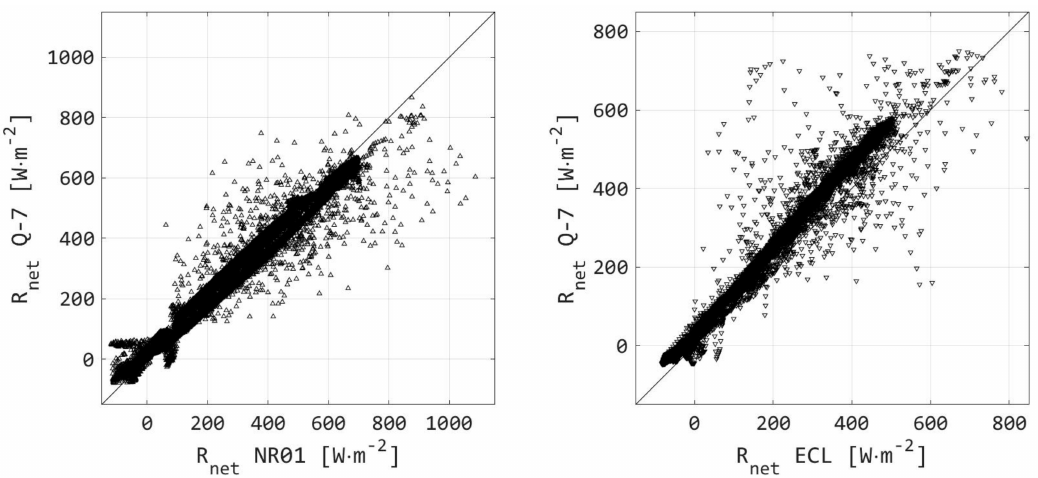
Figure 7. Comparison of NR01 ( x -axis) and Q-7 net radiometers during NN training periods (left) and during eclipse experiment